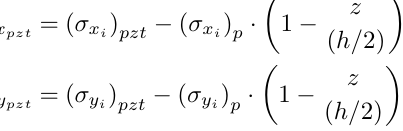
Fig. 13. Voltage time history due to center actuation by a wide PZT patch; (a) continuous sensor voltage for 2 ms, (b) continuous sensor voltage for 0.2